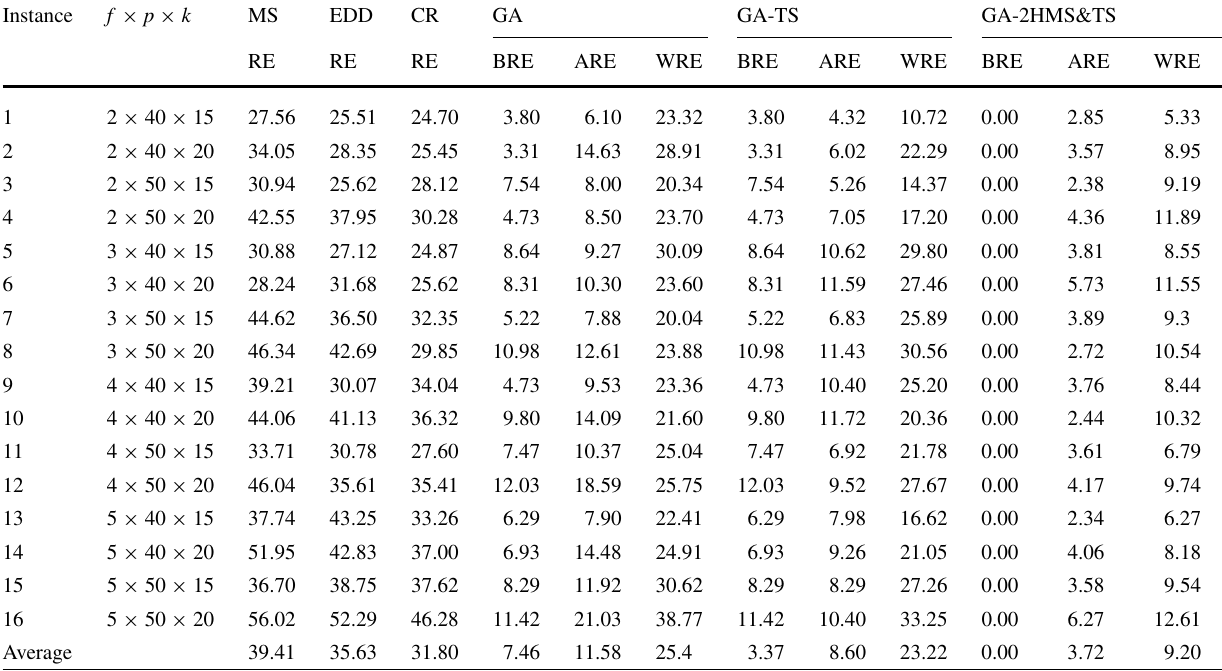
Table 8 RE value of different algorithms for large sized examples